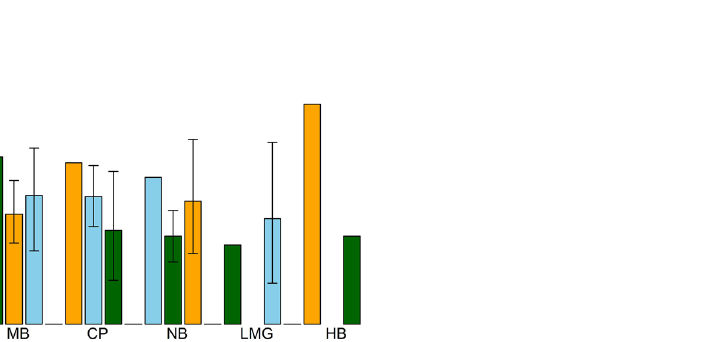
Figure 5. Flesh-footed shearwater breeding success in terms of chicks egg −1 on Lord Howe Island. (SP, Stevens Point; MB, Middle Beach; CP, Clear Place; NB, Neds Beach; LMBG, Little Muttonbird Ground; HB, Hunter Bay). (Confidence intervals for 2008 and 2014 is 95% Credible interval, no confidence intervals were indicated for 2002 by 9 , but similar methods were used to collect the